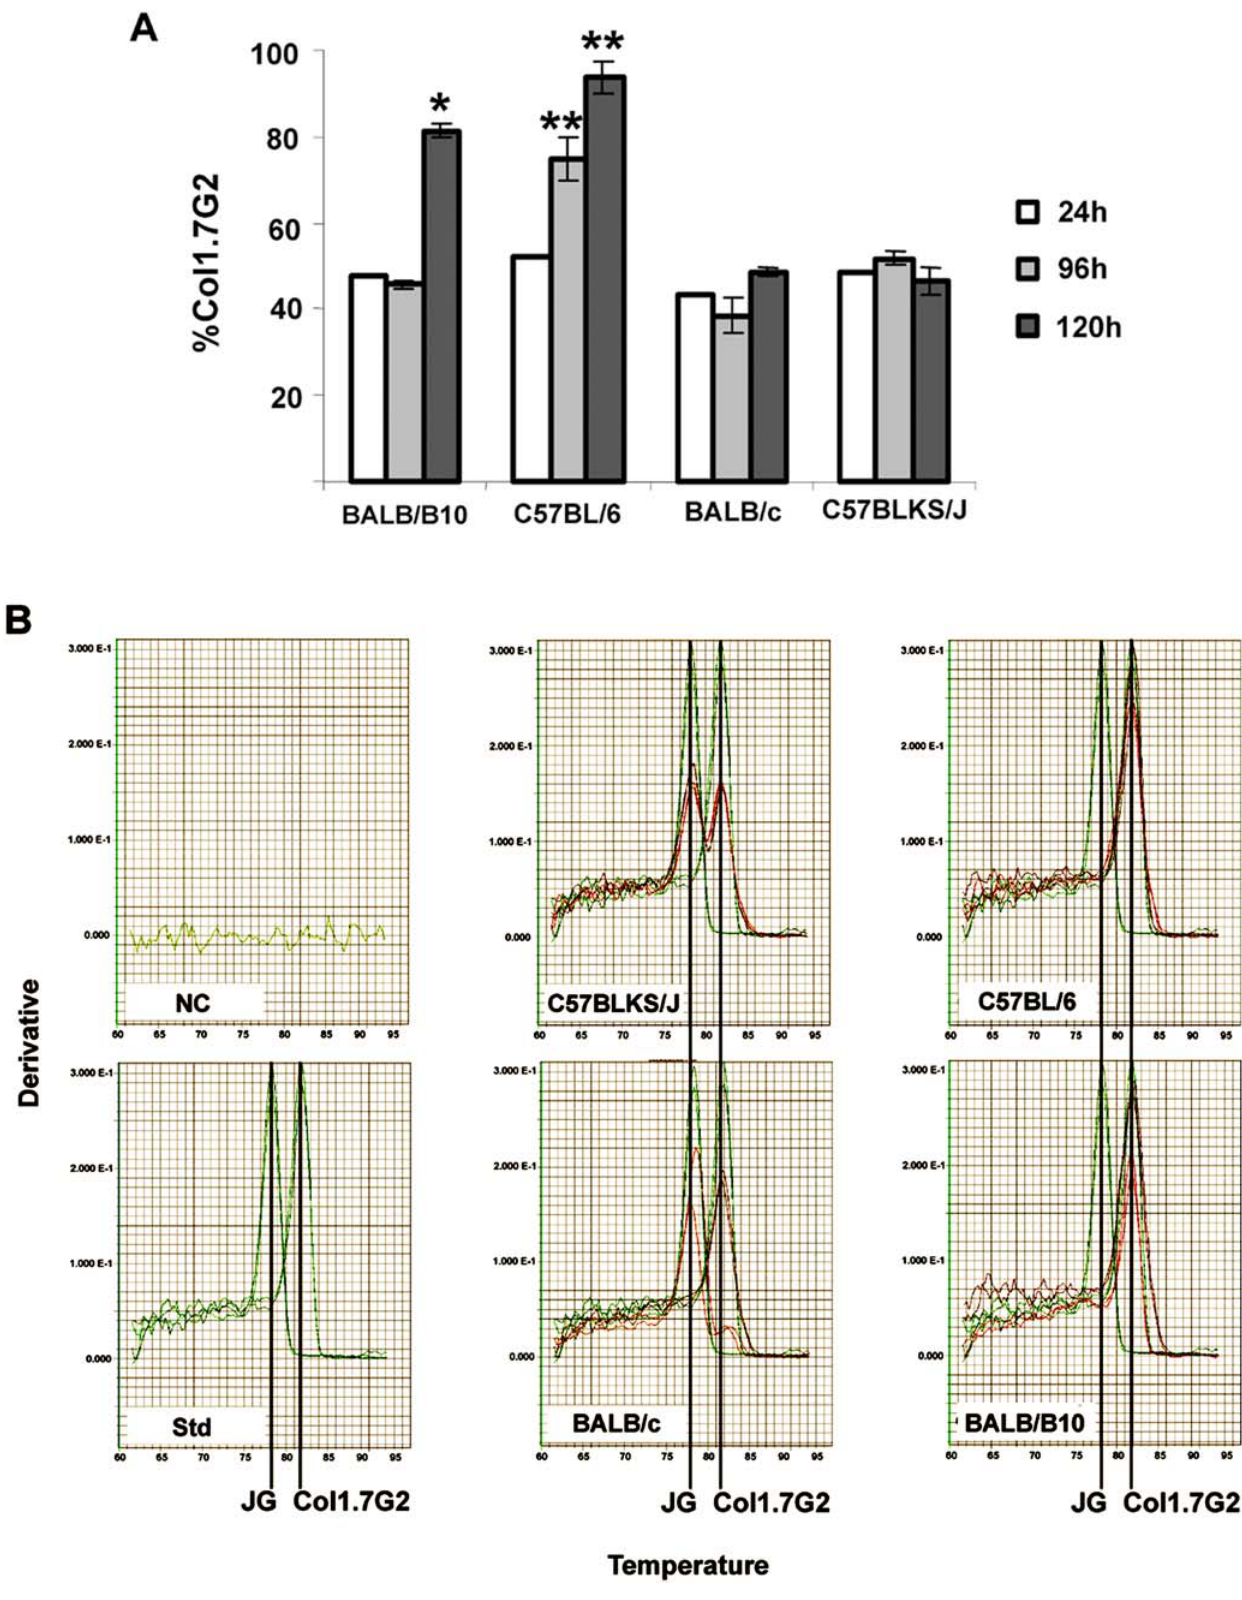
Figure 2. Quantitative analyses of the percentage of Col1.7G2 and/or JG after intracellular development in distinct murine cardiac explants exposed to equal mixture of trypomastigote forms of each population. (a) Relative percentage of the Col1.7G2 clone using the LSSP-PCR technique, 24, 96 and 120 h post-infection in murine cardiac explants. P values above the bars were obtained by the two-sample Student t